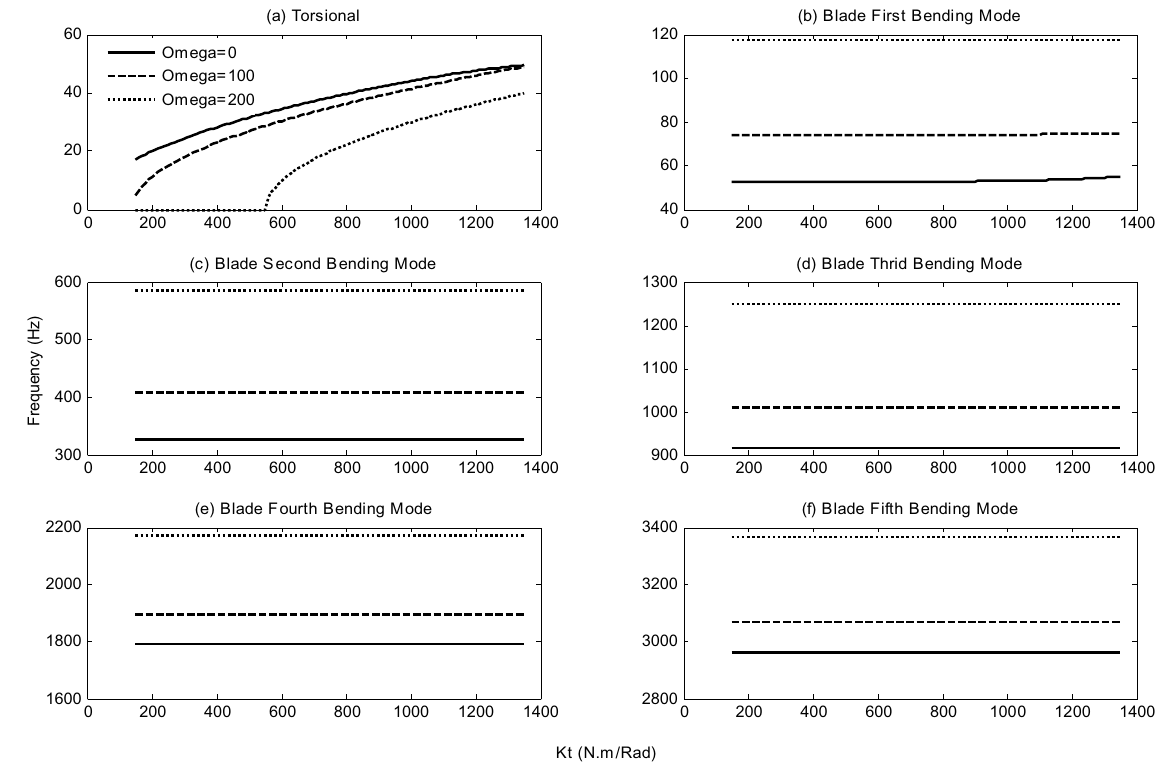
Fig. 3. Natural Frequencies as function of shaft torsional stiffness k T for rotating speeds. ω = 0, 100, 200